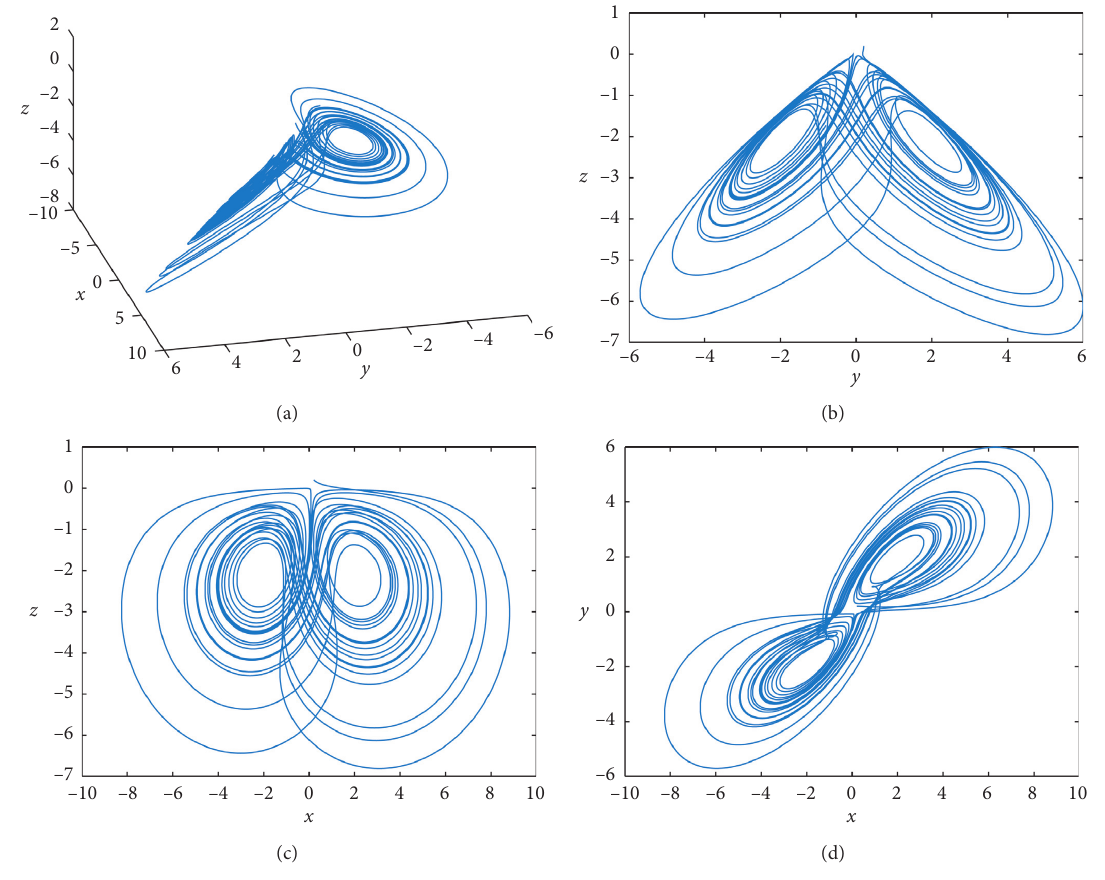
Figure 10: Phase portraits with the order α � 0 .